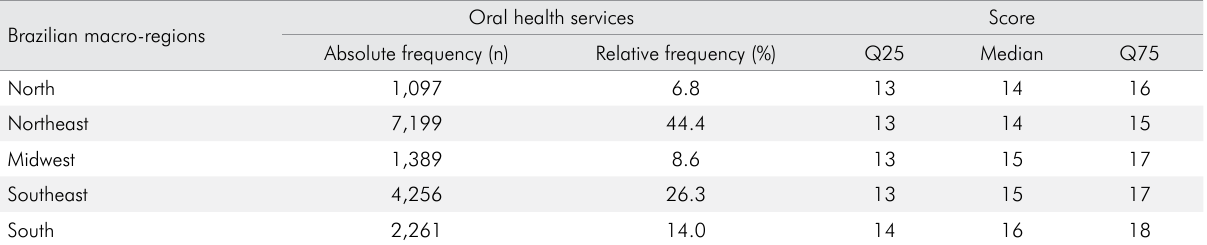
Table 2. Descriptive analysis of oral health services evaluated per macro-region and relevant scores for dental equipment. PMAQ-AB. Brazil. 2013-2014 (n =